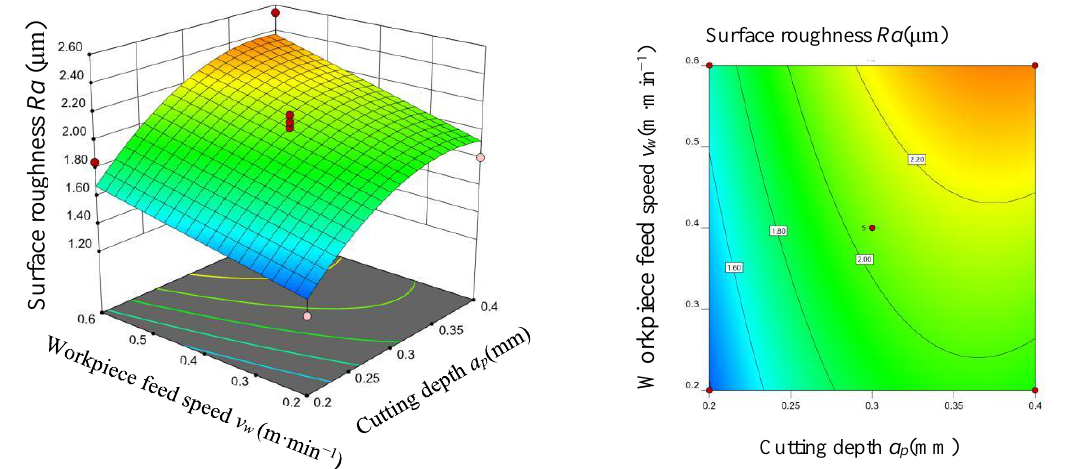
Figure 6. Cutting depth–workpiece feed speed response surface and contour map.